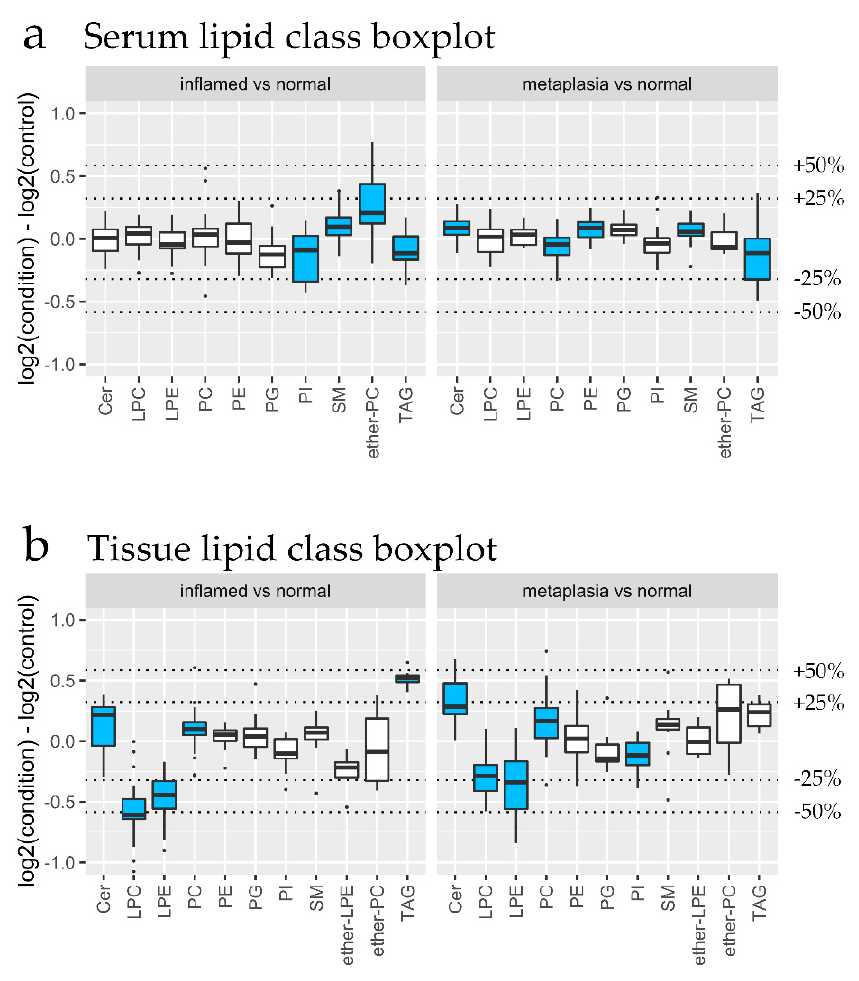
Figure 5. Lipid classes associated with gastroesophageal junction tissue pathology. ( a , b ) lipid class boxplots for serum and tissue lipids, showing the distribution of log2 differences between the disease condition and control. The disease conditions cardia and inflammation were visualized after applying the removeBatchEffect function from the limma R package. Positive values represent lipids that are more abundant in the disease condition group than in the control group. Blue color indicates significant enrichment using the fast gene set enrichment analysis (fgsea) method. Cer—Ceramide,